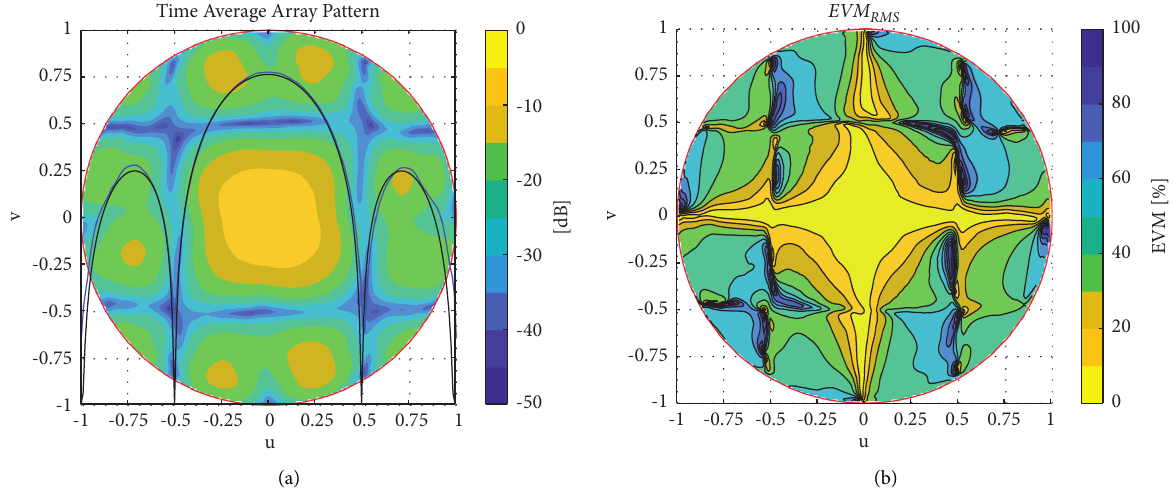
Figure 11: Nonsymmetric array performance including the measured demonstrator embedded element patterns: K � L � 4 and d � d � ( λ /2 ) . (a) Time average array pattern, where black and blue traces are cross sections at v � 0 with x y 0 pattern, respectively. (b) EVM.